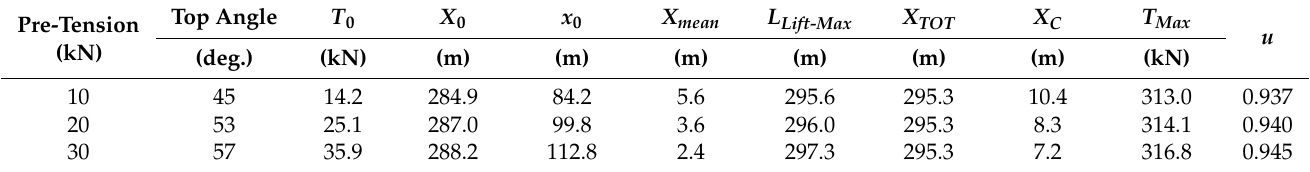
Table 15. Case 2, Minimum Diameter: D1 = 26 mm, D2 = 100 mm, D3 = 45 mm, quasi-static results.